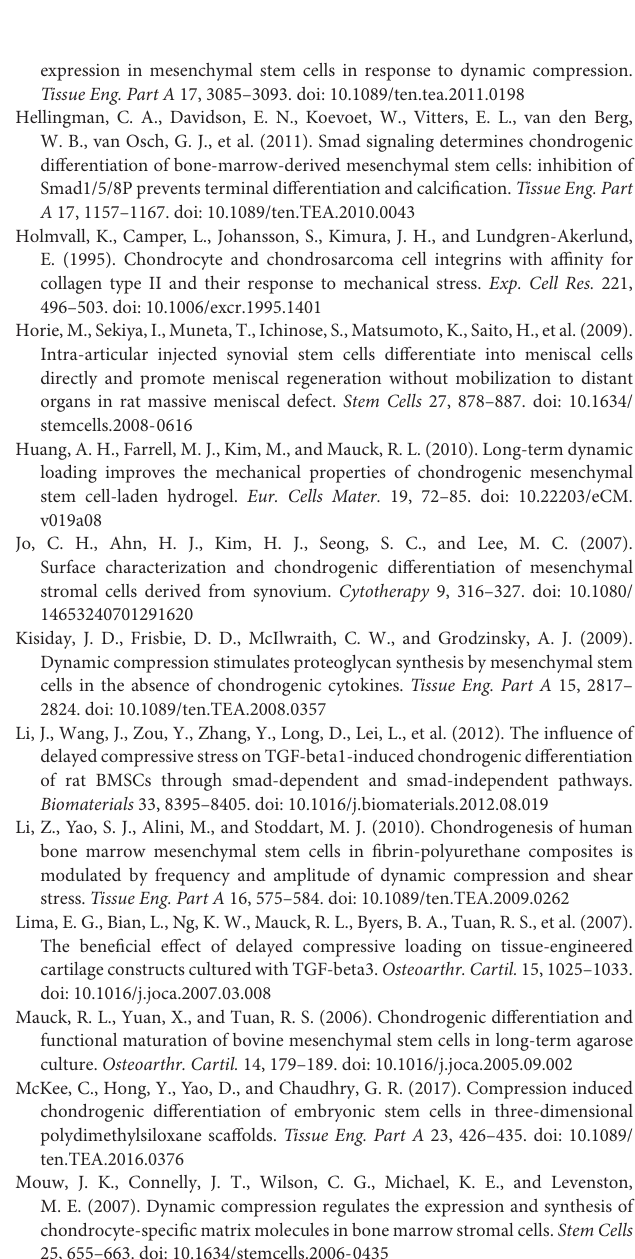
Supplementary Figure 1 | (A) Relative cell viability of SMSC construct after subjected to dynamic compression from day 1. (B) Relative cell viability of SMSC construct after subjected to dynamic compression applied after 3-week chondrogenic induction. Supplementary Figure 2 | Dynamic compression applied after 1-week chondrogenic induction inhibited both chondrogenesis and hypertrophy development of SMSCs. Gene expression of chondrogenesis and hypertrophy development. Results are presented as the mean ± S.D. * P < 0.05, ** P < 0.01, *** p < 0.001. COL2 α 1, collagen type II; SOX9, SRY-box transcription factor 9; COL1 α 1, collagen type I; COL10 α 1, collagen type X; RUNX2, RUNX family transcription factor 2; MMP13, metalloproteinases 13; ALP, alkaline phosphatase. Supplementary Figure 3 | Dynamic compression applied after 2-week chondrogenic induction inhibited both chondrogenesis and hypertrophy